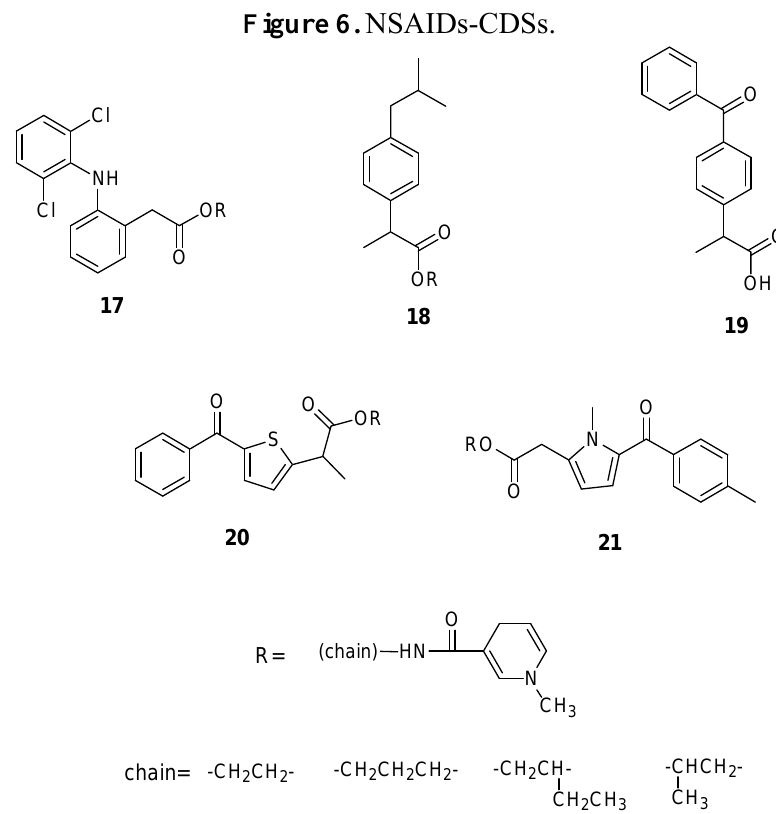
Figure 6. NSAIDs-CDSs.